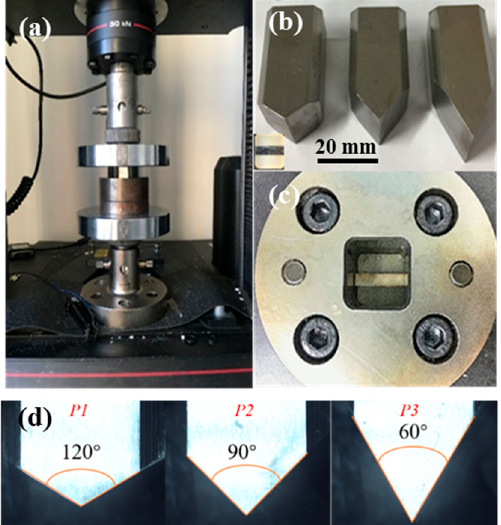
Figure 3. ( a ) Experimental platform, ( b ) punches, ( c ) die cavity, and ( d ) punch angles.